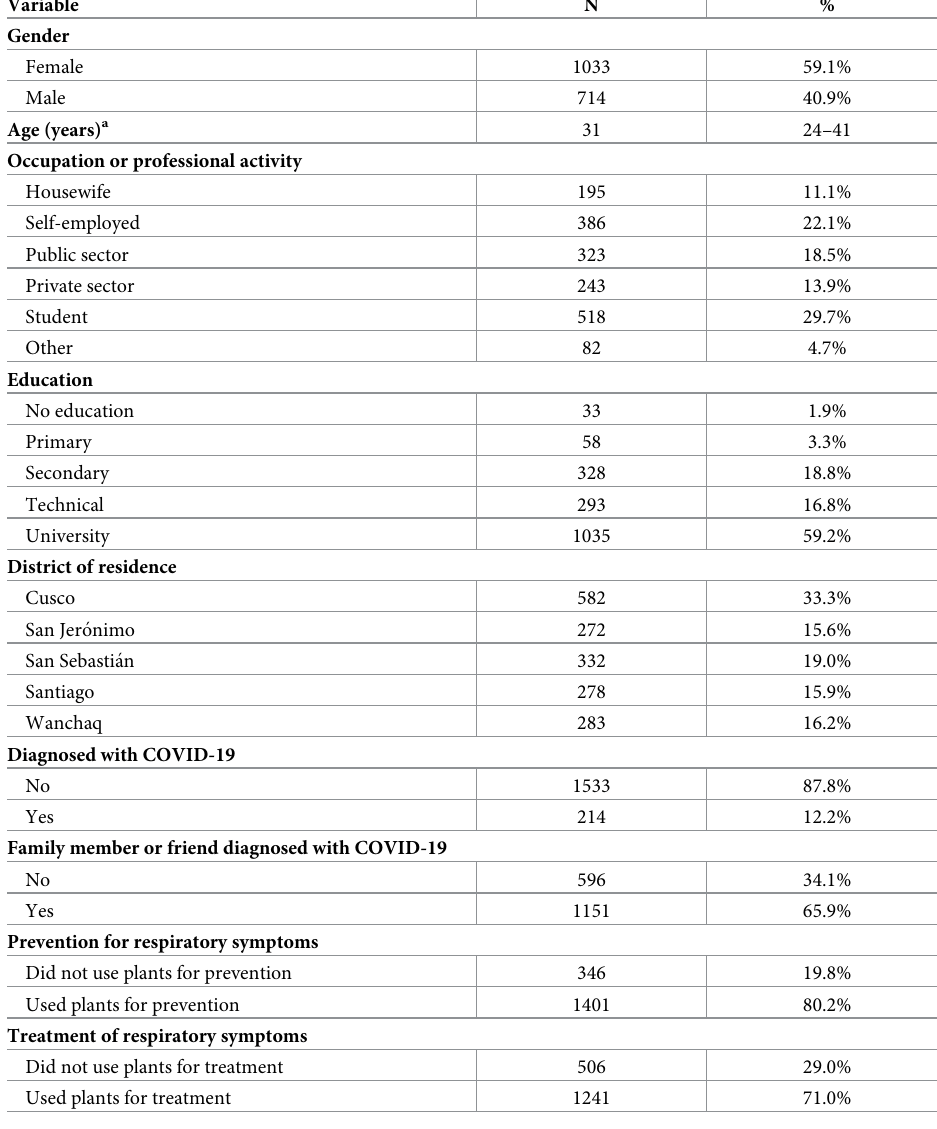
Table 1. Socio-demographic characteristics of respondents that used medicinal plants for the treatment or pre- vention of respiratory symptoms during the COVID-19 pandemic in Cusco, Peru. Variable